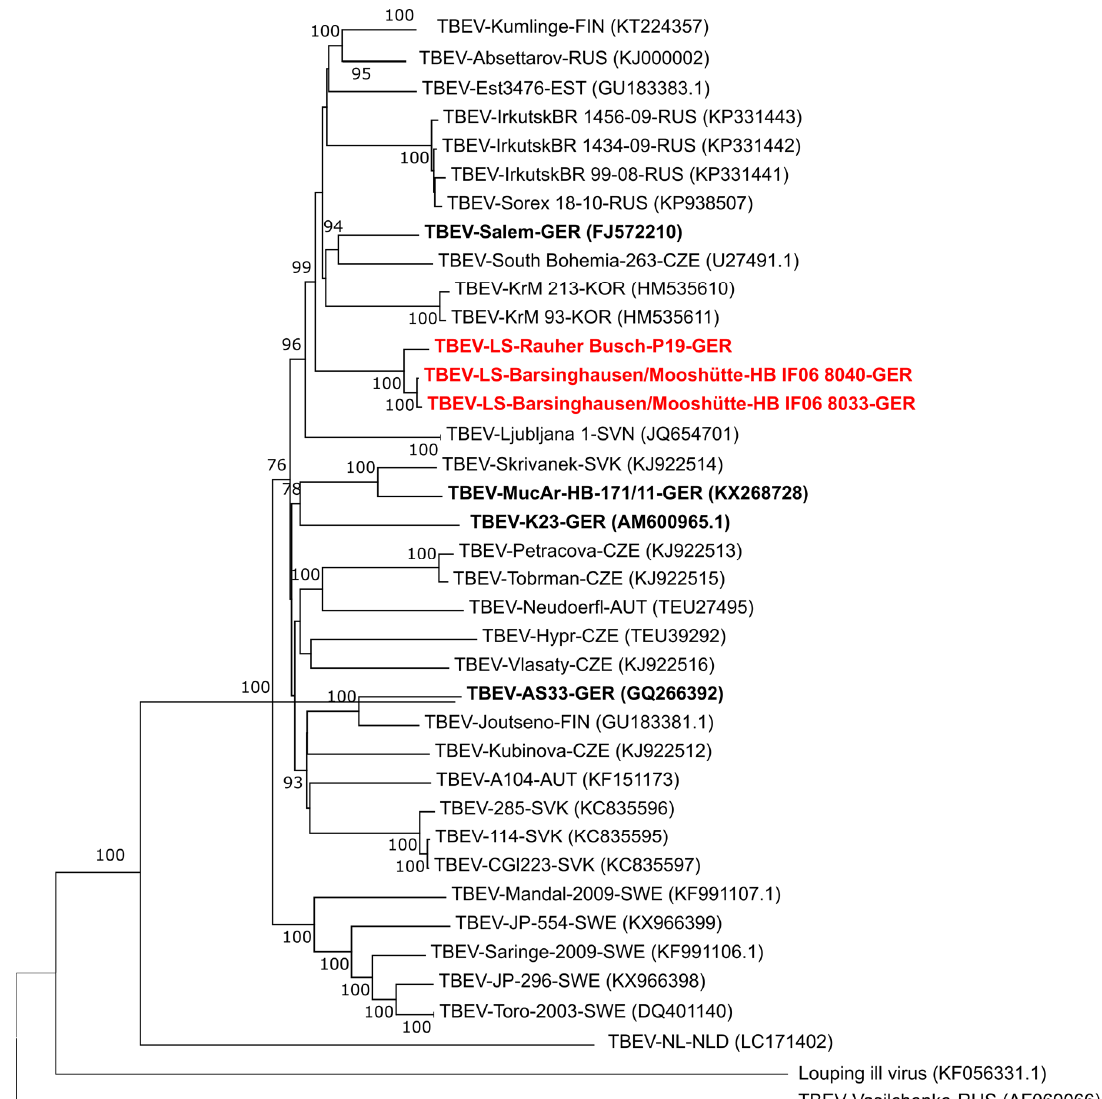
Figure 1. Phylogenetic tree of whole genome sequences available in GenBank and the two TBEV-LS- Barsinghausen/Mooshuette isolates HB IF06 8033 (MK922615) and 8040 (MK922616) and TBEV-LS- Rauher Busch P19 (MK922617) obtained in the present study (marked red). Virus isolate names